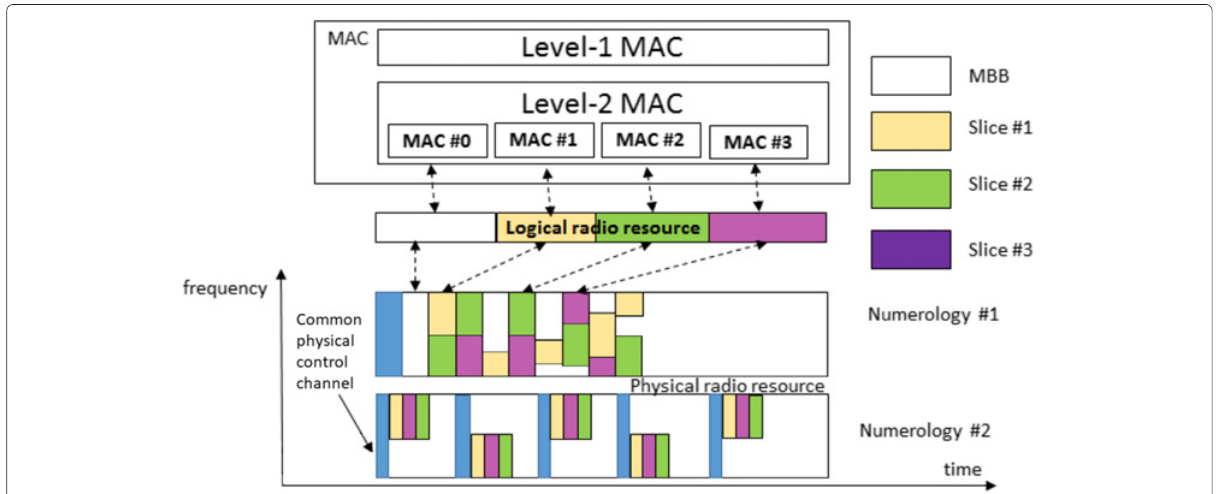
Fig. 2 Network slicing of air interface, based on [31]